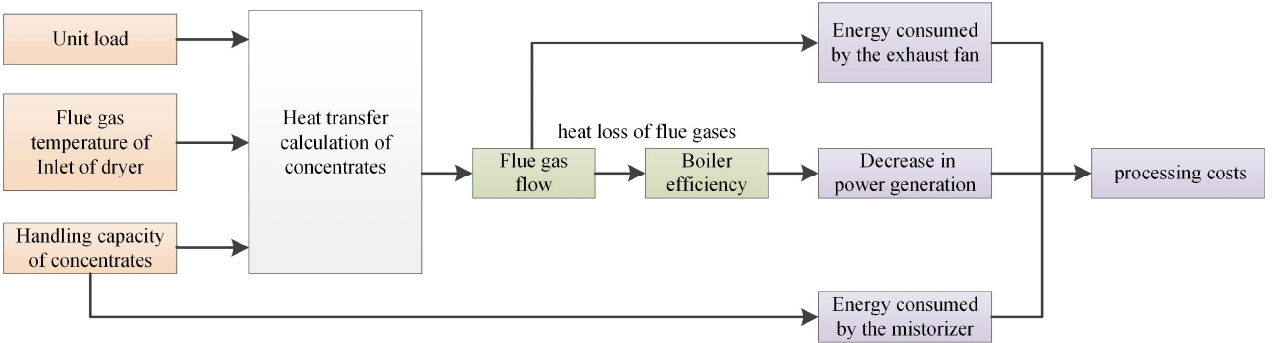
Figure 1. Flowchart of the cost calculation of the atomization drying system.